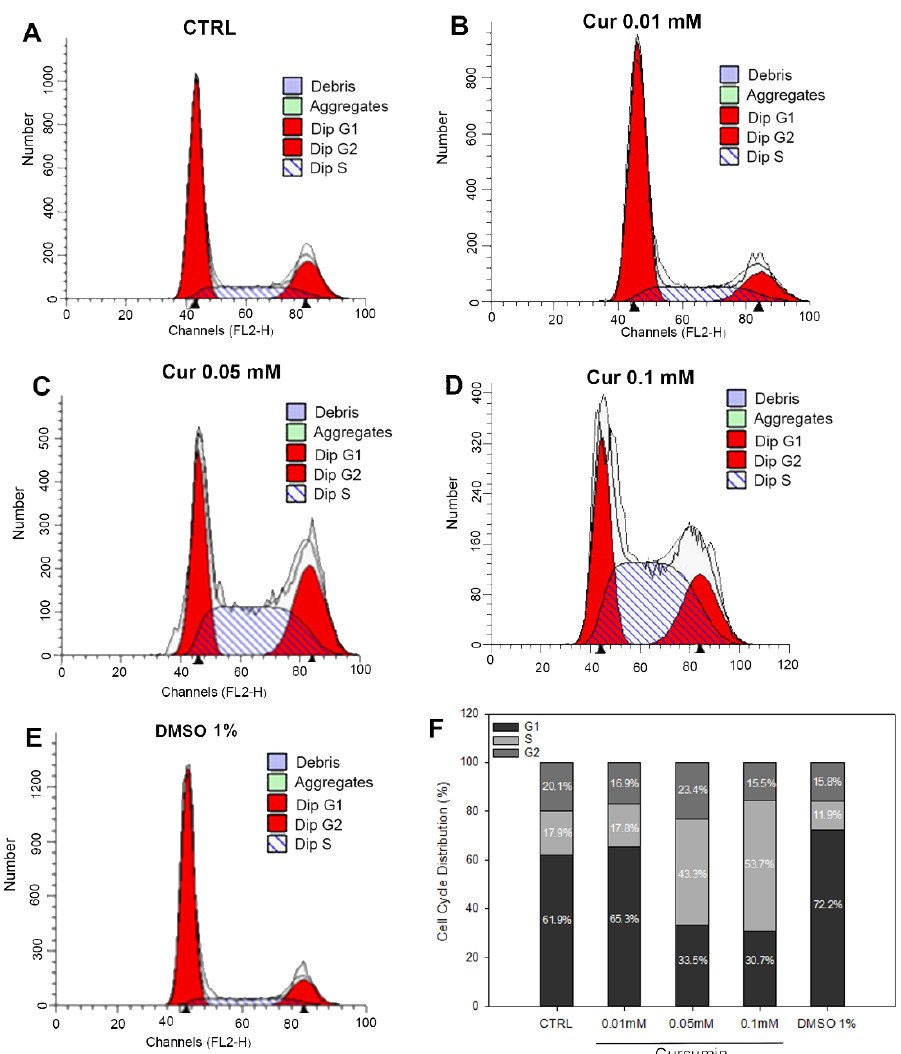
Figure 3. Cell cycle analysis obtained through flow cytometry. Representative profiles of cell cycle phases in ( A ) CTRL, ( B ) Cur 0.01 mM, ( C ) Cur 0.05 mM, ( D ) Cur 0.1 mM, ( E ) DMSO 1%. Debris and aggregates were not detected ( F ). Percentage distribution of Cur treated ARPE-19 cells within cell cycle phases. Representative profiles of cell cycle phases of all vehicles are reported in Figure S3.